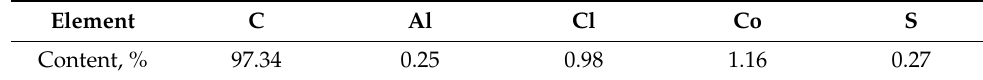
Table 2. Results of energy dispersive analysis of MWCNTs.